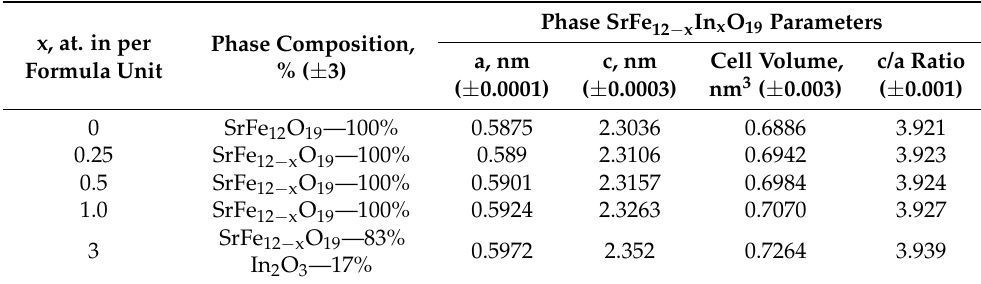
Table 1. The XRD results of SrFe 12 − x In x O 19 samples obtained by mechanochemical synthesis fol- lowed by annealing at 1200 ◦ C for 1 h.